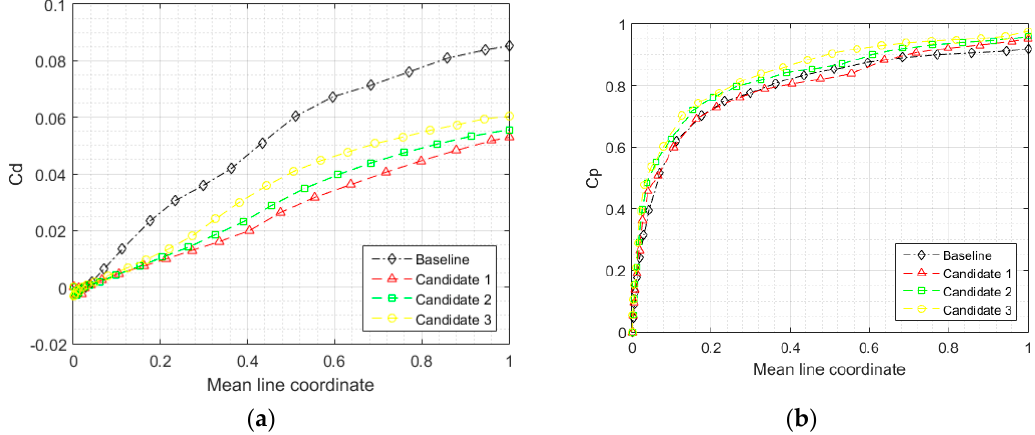
Figure 10. Post-check results on draft tube performance using full machine model: ( a ) C d distribution; ( b ) C p distribution.